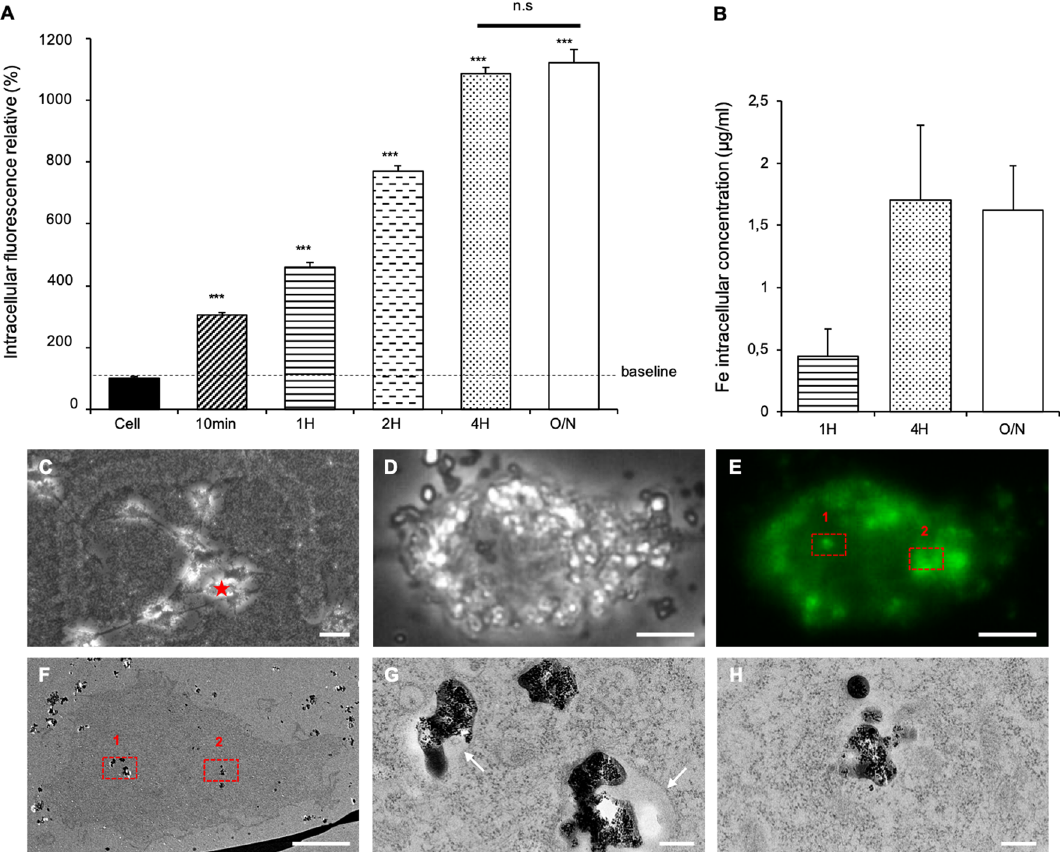
Figure 2. Analysis of the intracellular delivery of ScreenMAG particles in U87-MG cells. ( A ) Kinetic of ScreenMAG internalization quantified by flow cytometry (λ exc = 502 nm; λ em = 525 nm). Iron oxide particles (IOP) were incubated during different periods (10 min, 1, 2, 4 h or overnight (O/N)) and intracellular fluorescent relatives were quantified. ***Significantly different from the control ( P ≤ 0.01). ( B ) Fe intracellular concentration determined by an iron assay kit (Abnova, KA0814) at 593 nm. IOP were incubated during different periods (1 h, 4 h or overnight) before the iron concentrations were determined. ( C – F ) Correlative Light Electron Microscopy (CLEM) was used. Both fluorescence and electron microscopies were performed on the exact same cell (star in C ). ( C ) Lower magnification of cells in light microscopy. ( D ) Phase contrast and ( E ) Fluorescent image of a ScreenMAG-labeled U87-MG cell. ( F ) TEM section of the same cell. ( G , H ) Enlargements correspond to the two regions of interest (ROI) [(red squares 1 and 2 respectively in ( E ) and ( F )]. White arrows indicate the vesicular membranes. Scale bars are 40 μm ( C ), 5 μm ( D , E , F ) and 200 nm ( G , H